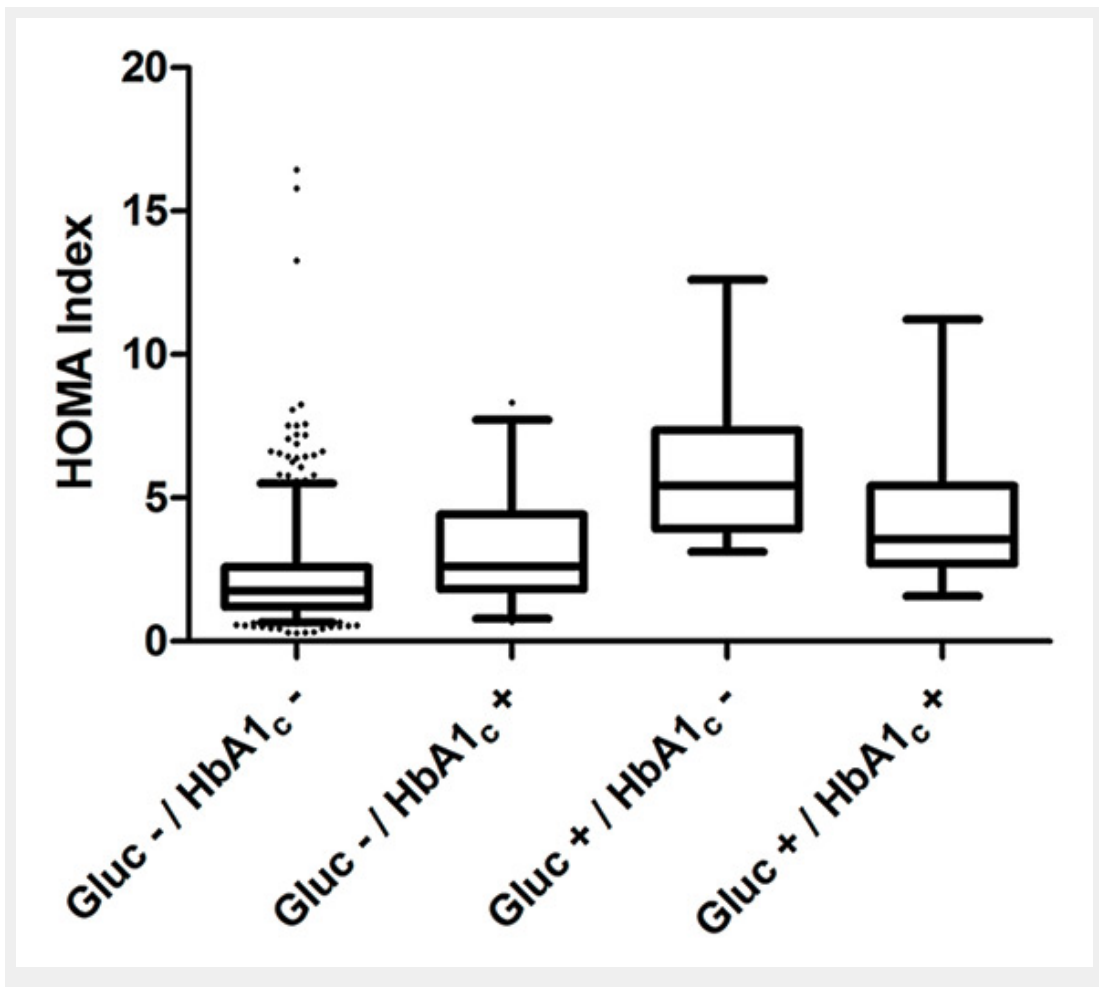
Figure 3 HOMA index according to a diagnosis of T2DM, as obtained from measurement of FPG and HbA 1c . Gluc + indicates a FPG ≥7 mmol/l, whereas HbA 1c + indicates an HbA 1c ≥6.5%. Individuals meeting one or two diagnostic criteria had significantly higher HOMA indices than individuals without indication of T2DM. FPG = fasting plasma glucose; Gluc = glucose; HbA 1c = glycated haemoglobin; HOMA = homeostasis model assessment; T2DM = type 2 diabetes